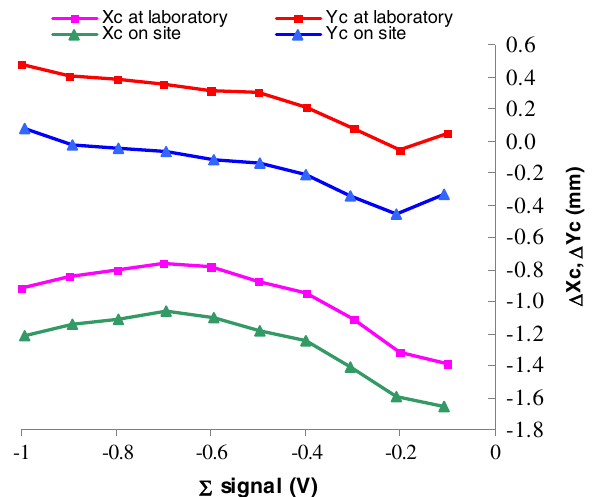
Þ versus intensity. We com- ; (cid:2) y FIG. 22. (Color) Offsets ð (cid:2) x c c pare the measurements performed at the test stand (in laboratory) and after final installation (on site). The cable length used for the test stand was 19.10 meters. The major difference between the measurements is due to the different bendings of the coaxial cables running between the BPM block and the readout elec- tronics.